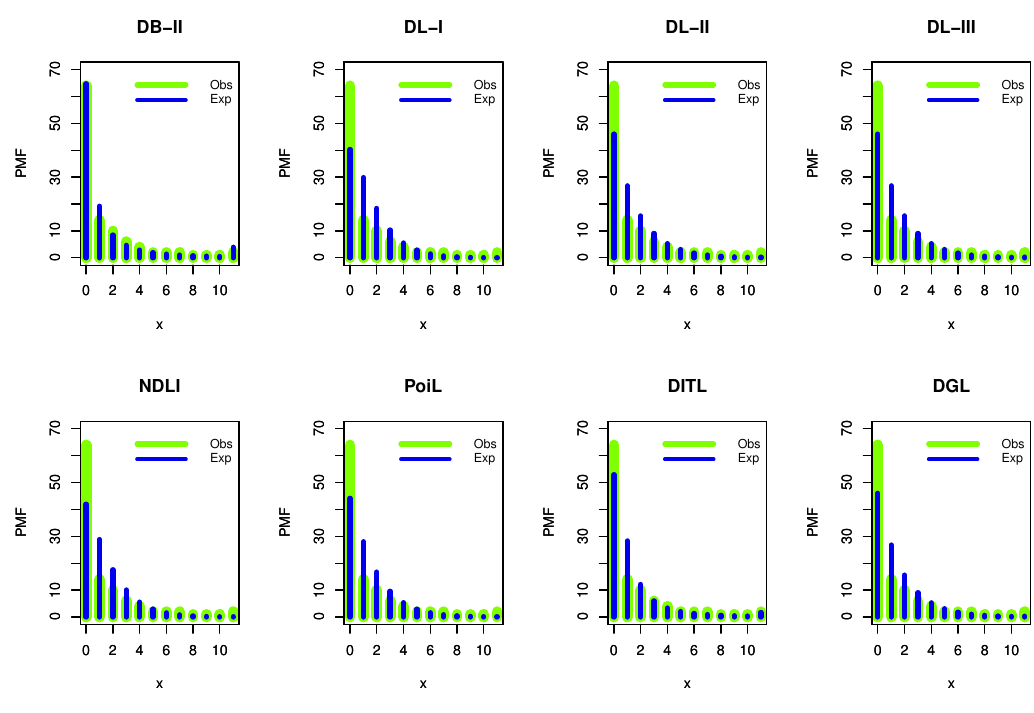
Figure 7. Estimated PMFs for the